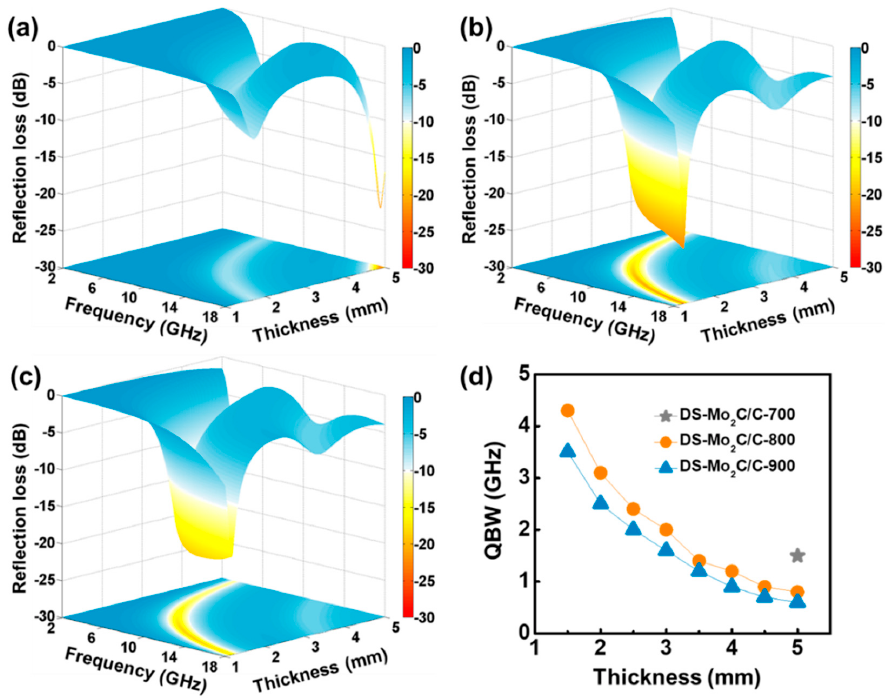
Figure 4. Three − dimensional reflection loss maps of DS − Mo 2 C/C − 700 ( a ), DS − Mo 2 C/C − 800 ( b ), and Figure 4. Three-dimensional reflection loss maps of DS-Mo 2 C/C-700 ( a ), DS-Mo 2 C/C-800 ( b ), and DS − Mo 2 C/C − 900 ( c ); The QBW at the specific thickness of DS − Mo 2 C/C − 700, DS − Mo 2 C/C − 800, and DS-Mo 2 C/C-900 ( c ); The QBW at the specific thickness of DS-Mo 2 C/C-700, DS-Mo 2 C/C-800, and DS − Mo 2 C/C − 900 ( d ). DS-Mo 2 C/C-900 ( d